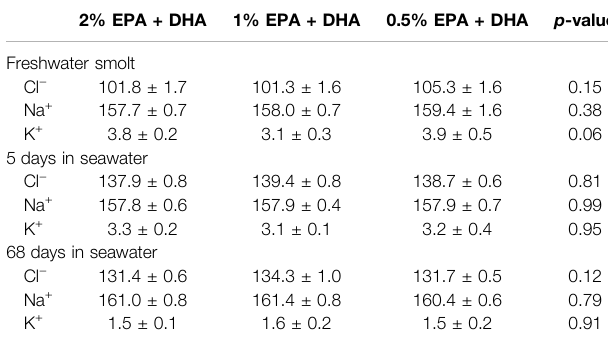
TABLE 3 | Plasma ion levels (mM) of Atlantic salmon fed different levels ofomega- 3,infreshwatersmolts2 – 4 daysbeforeseawatertransfer,5and68 daysafter transfer of fi sh to